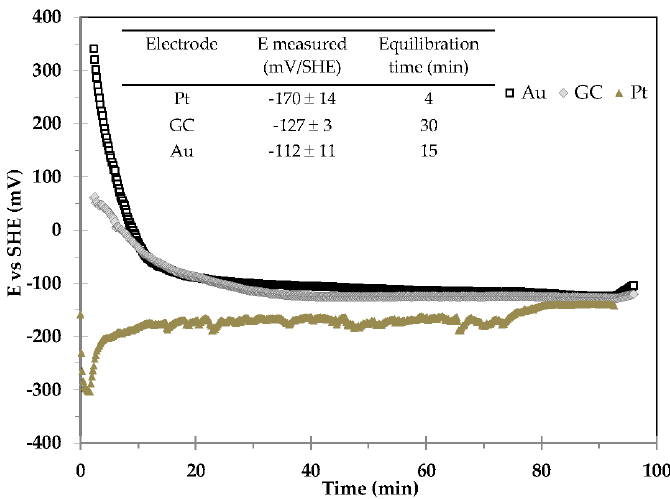
Figure 9. Evolution of Au, GC and Pt OCP electrodes as a function of time. The experiment was conducted in 0.1 M NaCl solution containing 100 mg of Fe° powder at pH 8 and 25 °C, in the glove box.